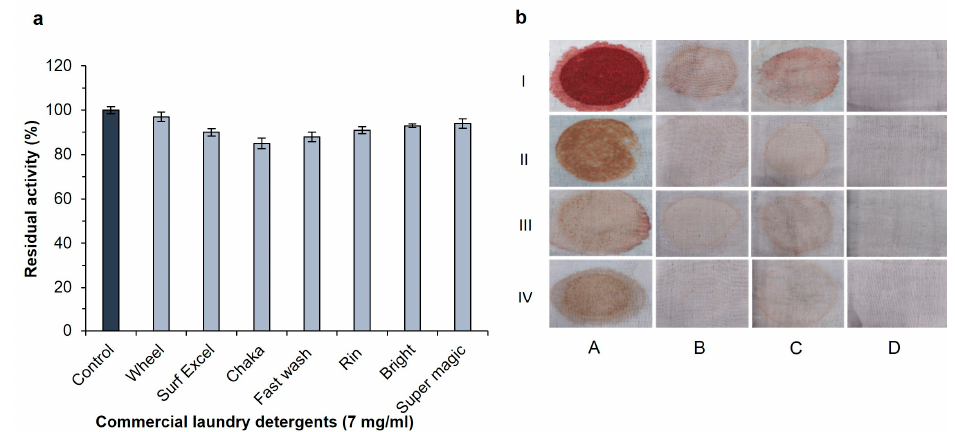
Figure 5. ( a ). Effect of several solid industrial laundry detergents on protease SH21 from Bacillus siamensis CSB55. To check the stability of protease in the presence of some industrial solid laundry detergents, the enzyme was incubated with or without detergents at room temperature for 24 h, and residual activity was determined under standard assay conditions. Each value represents the mean (n = 3) ± standard deviation. ( b ) Stain removal ability of SH21. Stained clothes with (I) blood, (II) chocolate, (III) jam, and (IV) tomato sauce, where (A) control (untreated stained clothes pieces or treated with, (B) enzyme alone (200 U/mL), (C) Wheel detergent alone (7 mg/mL), (D) Wheel detergent (7 mg/mL) + enzyme (200 U/mL).